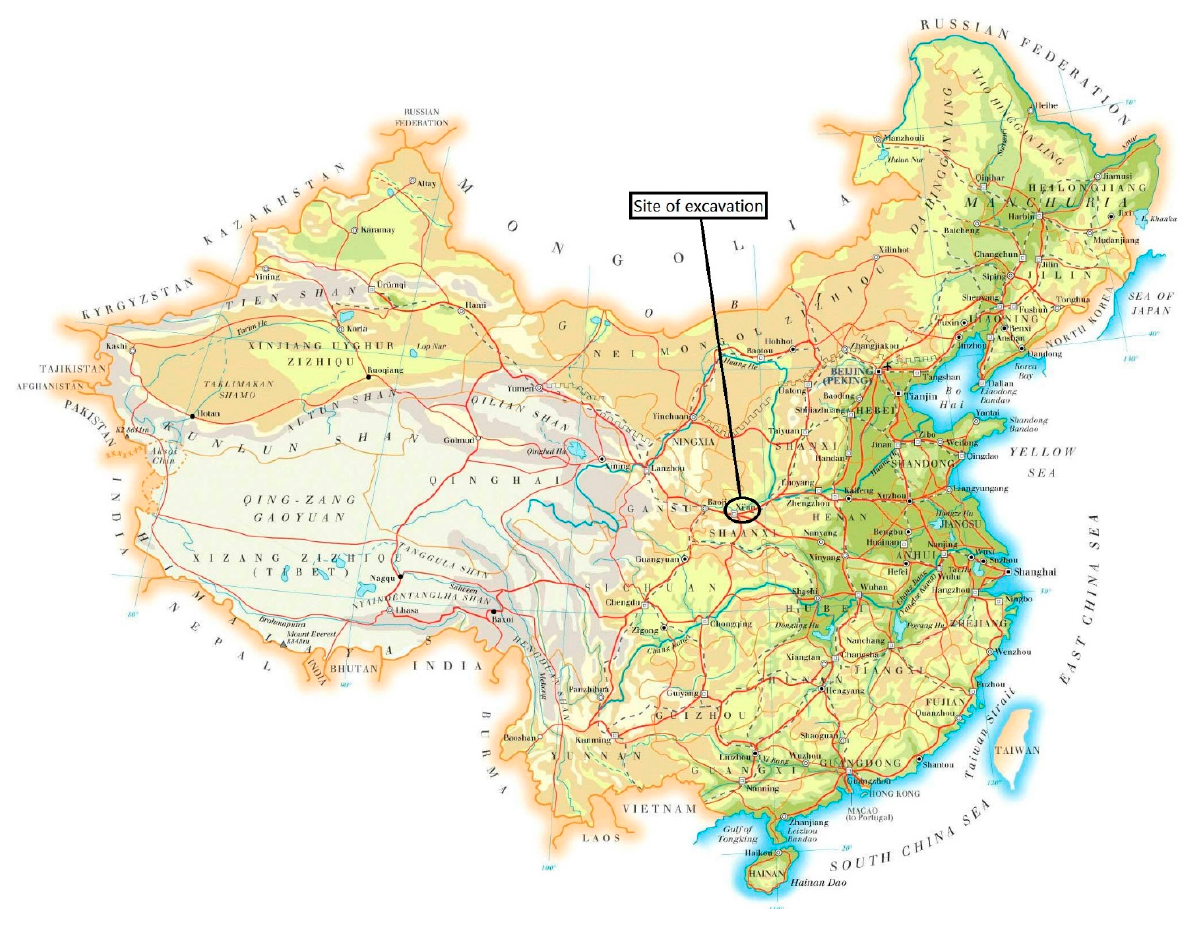
Figure 2. Location of the excavation site.